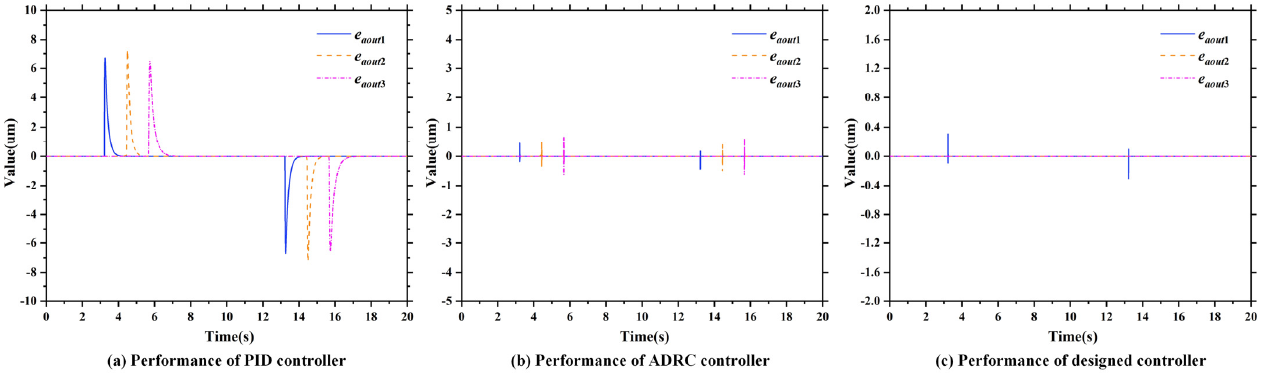
Figure 10. The register error curves under tension disturbance (150 m/min).